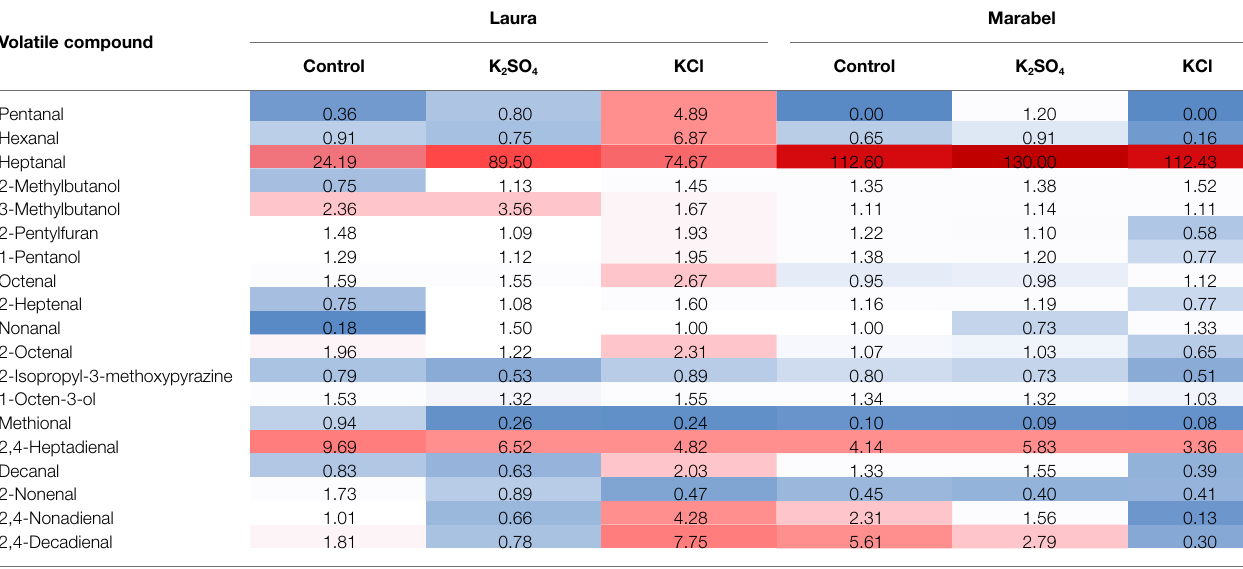
TABLE 3 | Fold changes of volatile compounds comparing raw potato tubers at harvest in 2020 with raw tubers after 5 months of storage at 6 ° C depending on fertilisation and cultivar. Laura Marabel Volatile compound Control K 2 SO 4 KCl Control